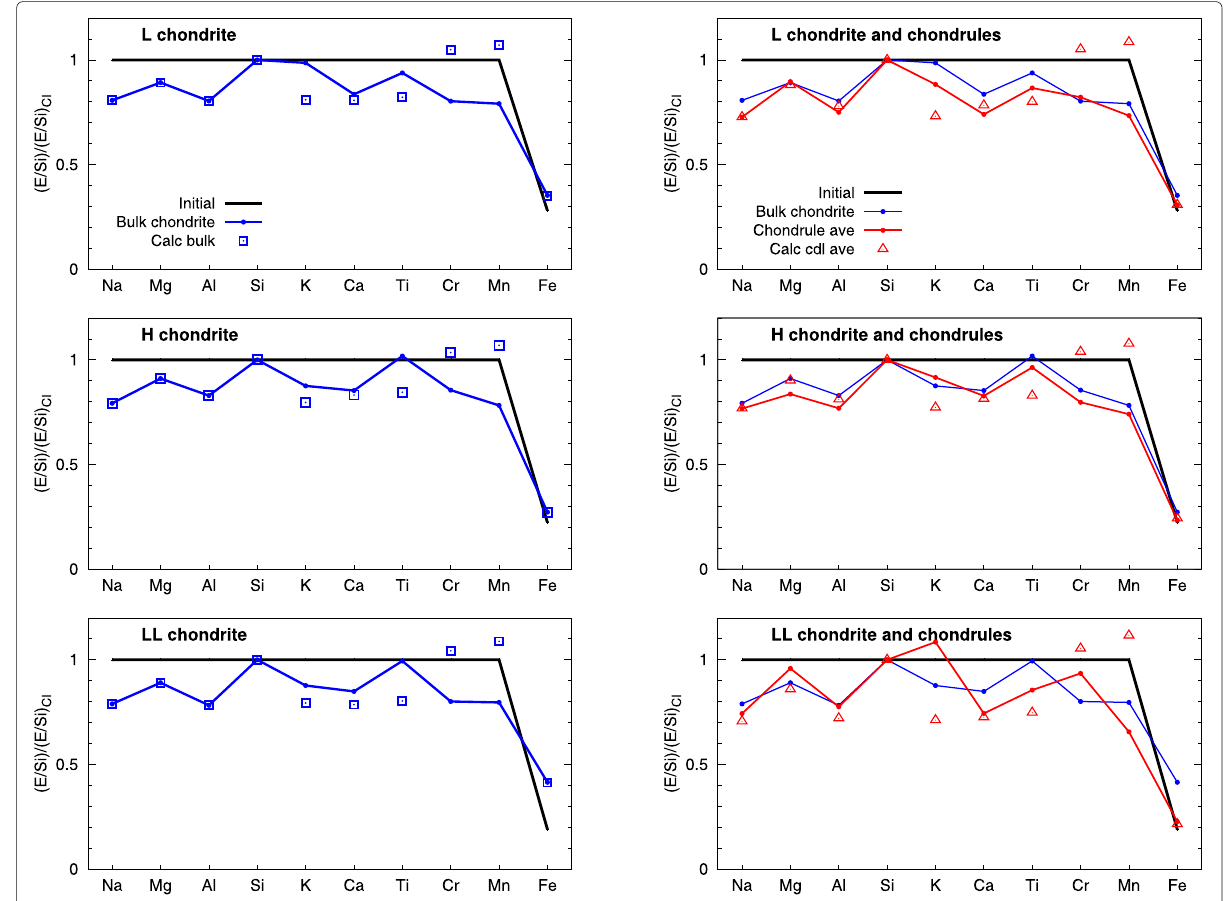
Fig. 1 Results of numerical fittings for L, H and LL chondrites, as compared to the composition of real chondrites. (E/Si)/(E/Si) CI indicates (element concentration normalized to Si concentration) of a substance divided by (element concentration normalized to Si concentration) of CI chondrite. Initial: initial composition used in the calculation. Bulk chondrite: average bulk composition of a specified chondrite type (e.g., L chondrite). Chondrule ave: average composition of chondrules which belong to a specified chondrite type. Calc bulk: calculated bulk composition of a specified chondrite type. Calc cdl ave: calculated average composition of chondrules of a specified chondrite